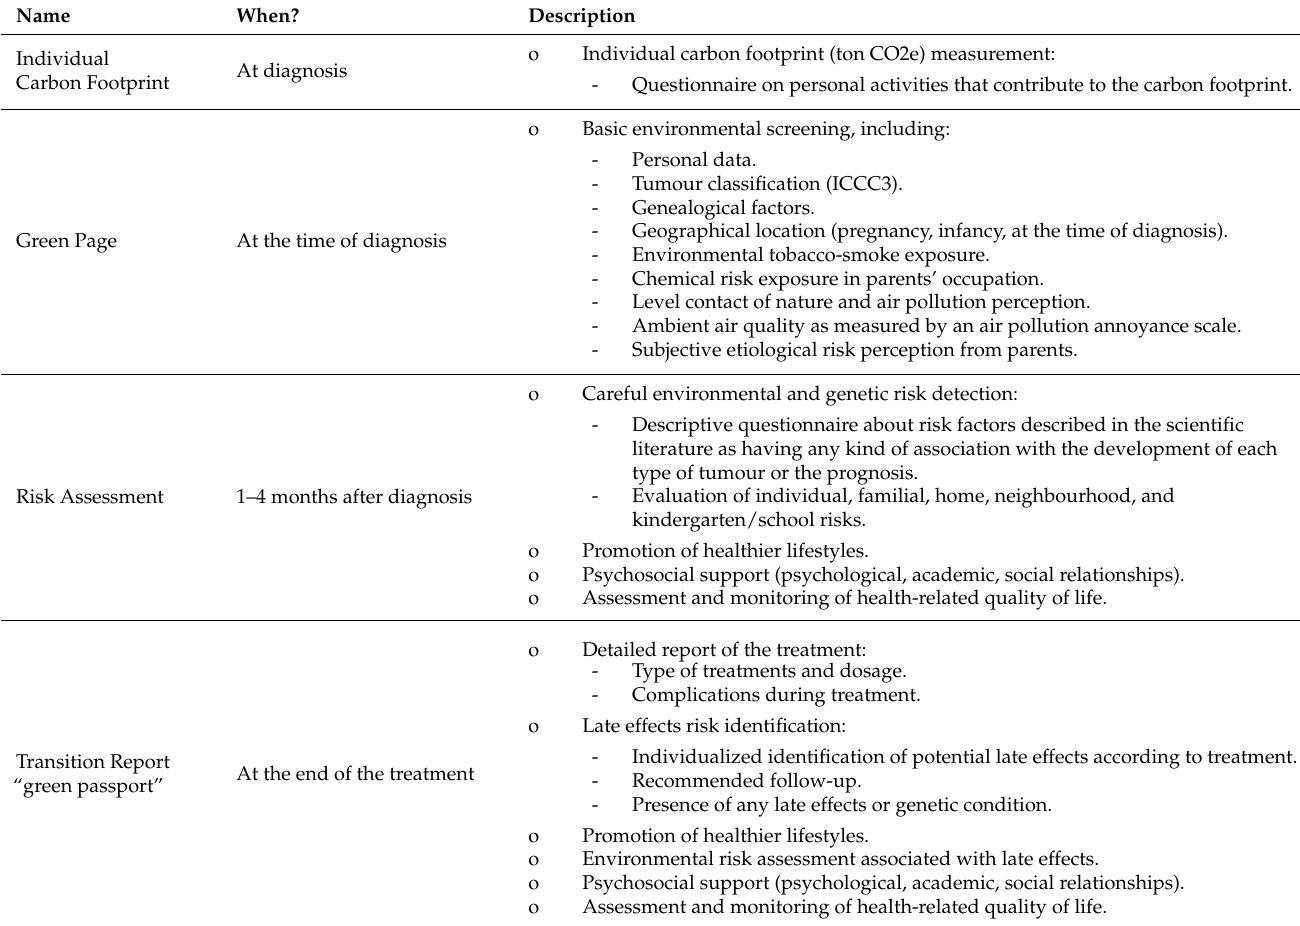
Table 1. Individual carbon footprint, Green Page, risk assessment, transition report, and individual- ized long-term follow-up